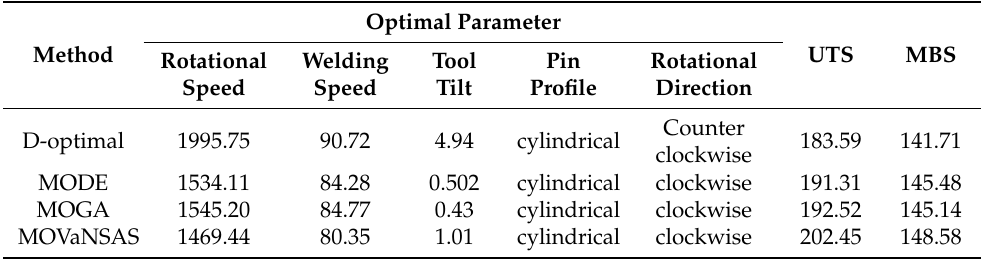
Table 12. The prediction result of optimal welding condition of each heuristic. The computational results of the ultimate tensile strength of each